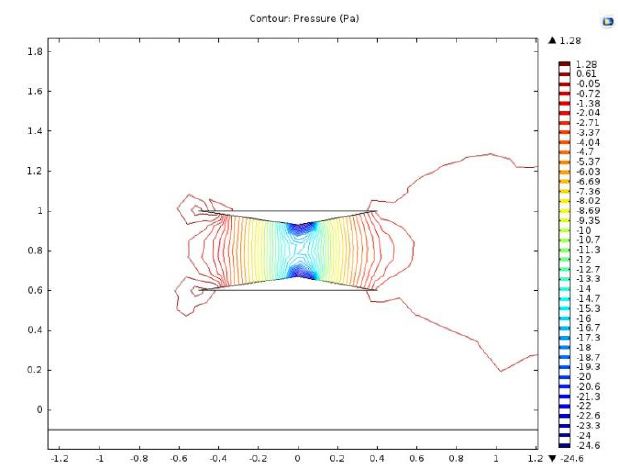
Figure 5. Pressure loops diagram of the air flow